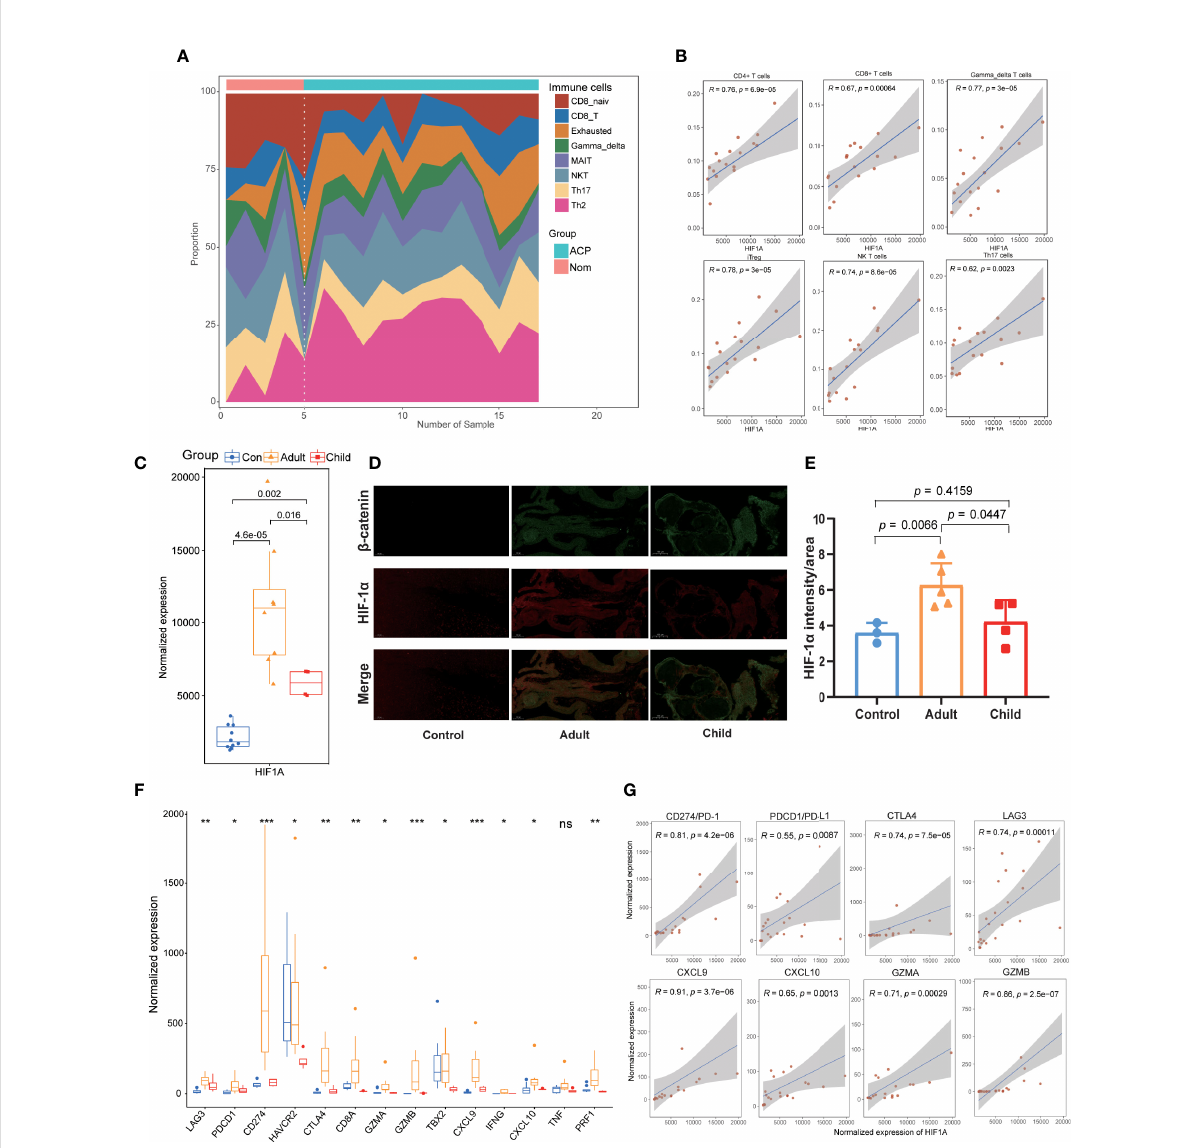
FIGURE 5 Validation of HIF-1 a ’ s immunological characteristics and the correlation with special age distribution. (A) . Our own sequencing data validated the in fi ltration of multiple immune cells in the tissues of ACP patients including B cells, CD4+ T cells, CD8+ T cells, Th17 cells, NK T cells, gamma – delta T cells, and Th2 cells. (B) . The correlation analysis revealed that HIF-1 a was signi fi cantly positively associated with the in fi ltration of multiple immune cells. (C) . Higher expression levels of HIF-1 a were detected in adult-ACP than that of children patients. (D, E) . Immuno fl uorescence staining validated higher levels of HIF-1 a in adult-ACP than that of children patients. (F) . The expression levels of immune checkpoints and in fl ammatory factors were signi fi cantly upregulated in the adult-ACP patients than child subtypes and controls. (G) . HIF-1 a exhibited a positive relationship to the expression of immune-associated genes. *p < 0.05; **p < 0.01; ***p < 0.001; ns, no signi fi